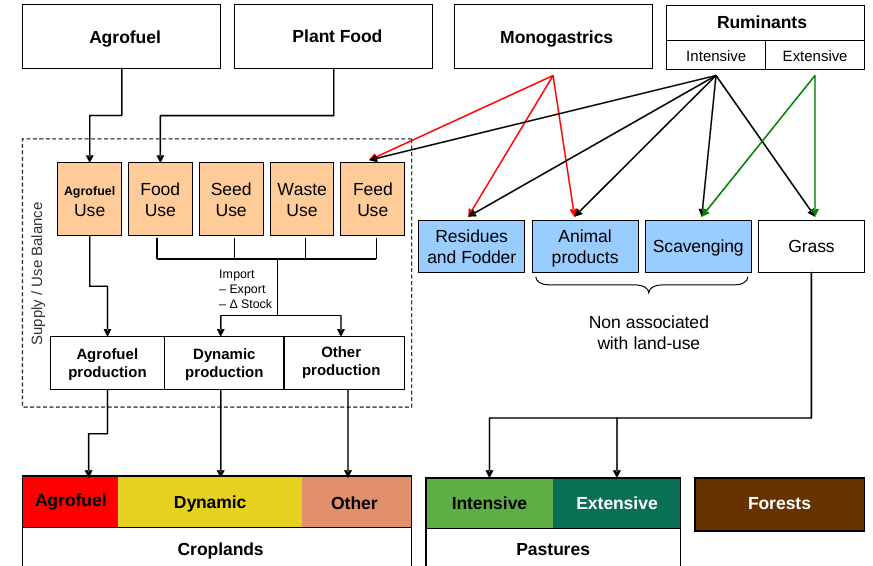
Fig. 3. Links between food and agrofuel demand and land-use. Table 2. Mean of food crop production over the period 1999–2003 from Agribiom and LPJmL production according to actual yields